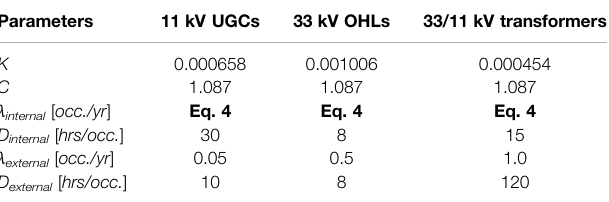
TABLE 1 | Reliability parameters of the distribution assets in the modi fi ed